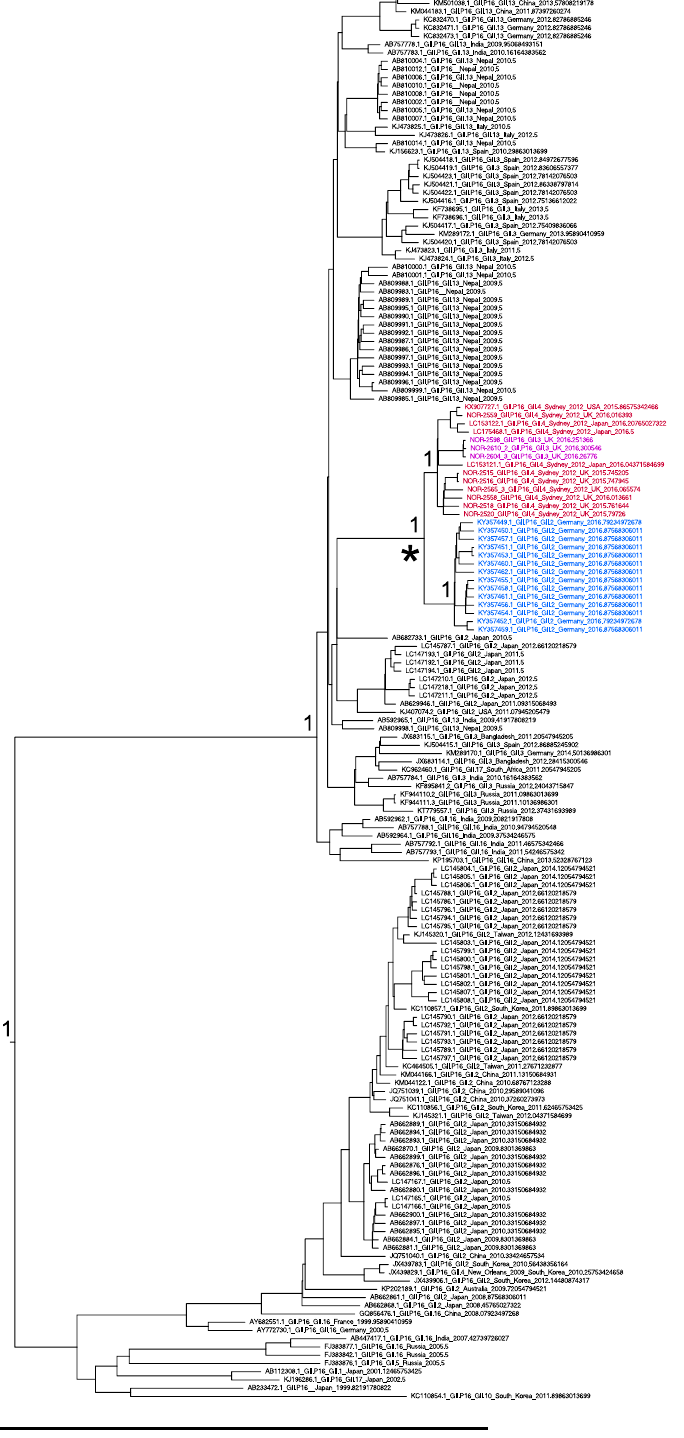
Fig 1. Evolutionary history of the GII.P16 lineage. Time tree of 179 GII.P16 RdRpsequences reconstructed using BEAST 2. The GII.P16 samplesfound with the GII.4 Sydney 2012 capsid are highlighted red. The GII.P16 samples found with the GII.3 capsid are highlightedin magenta. The GII.P16-GII.2 samples